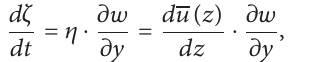
where (𝜉, 𝜂, 𝜁) are vorticities in the (𝑥, 𝑦, 𝑧) directions, respec- tively, and 𝑤 is the z -component of velocity. In the right hand side (RHS) of (1), the first two terms represent the tilting motion of a horizontal vortex tube by a vertical shear of horizontal wind, and the third term represents the stretching motion of the vertical vortex tube due to variable 𝑤 in the 𝑧 -axis direction. Vorticity motion is three-dimensional, and all components are nonlinearly coupled with each other, but for the sake of clear explanation only the vertical vorticity equation is presented